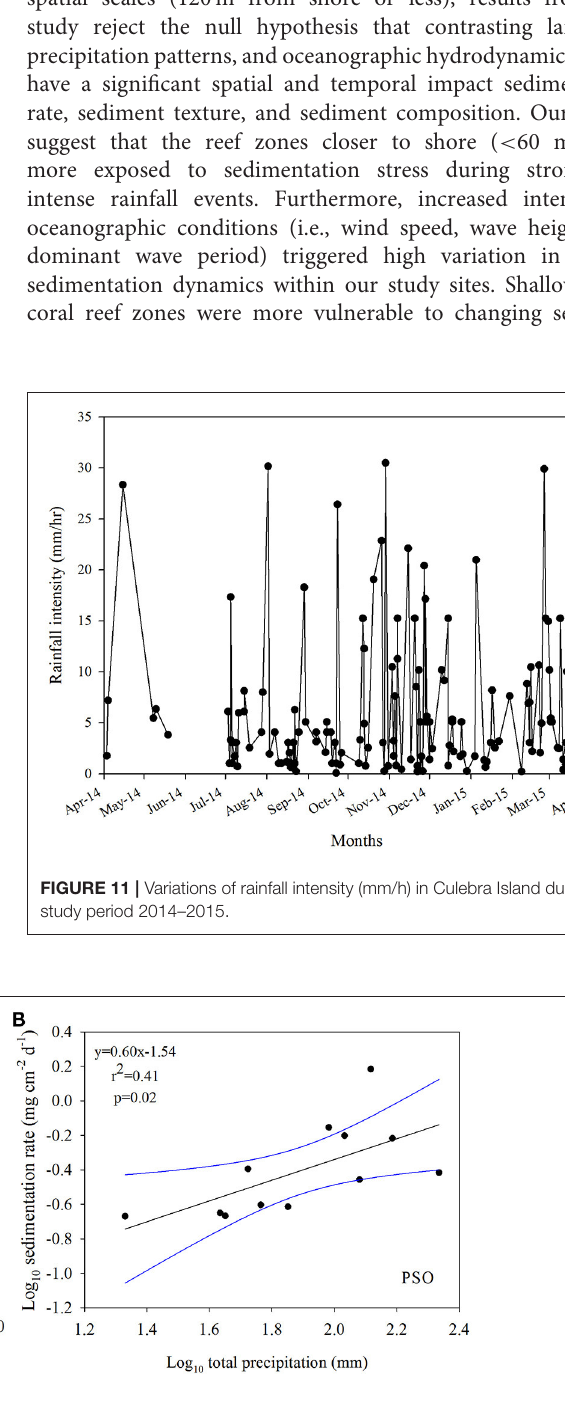
Frontiers in Marine Science |